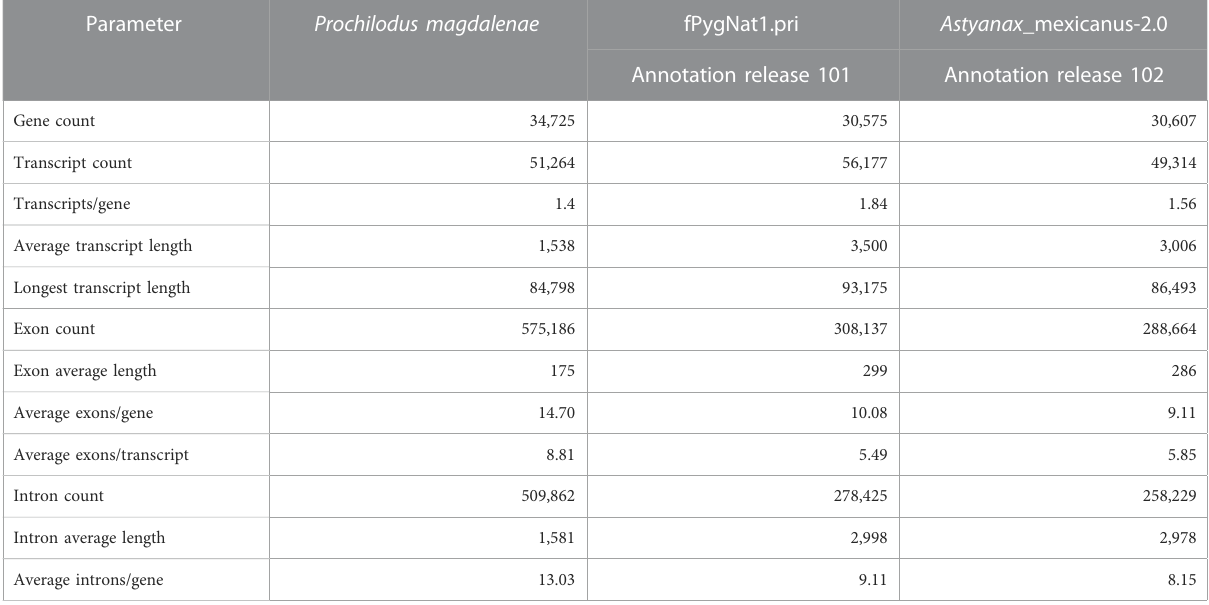
TABLE1Comparativegeneannotationmetricsfor P.magdalenae anditsclosestcounterpartsredpiranha( Pygocentrusnattereri )andblindcave fi sh( Astyanax mexicanus ), both with chromosome level assemblies and BUSCO completeness values over